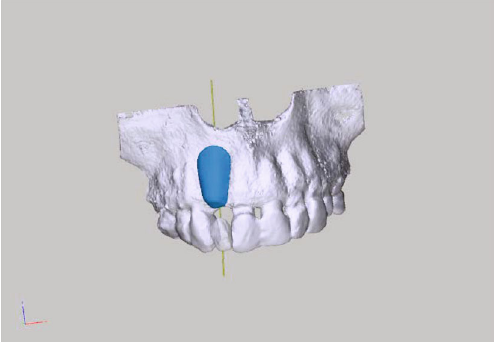
Figure 5: Rendered 3D planning model (STL fi le) with 3D bonebuilder block graft (3D BB) in position 12.